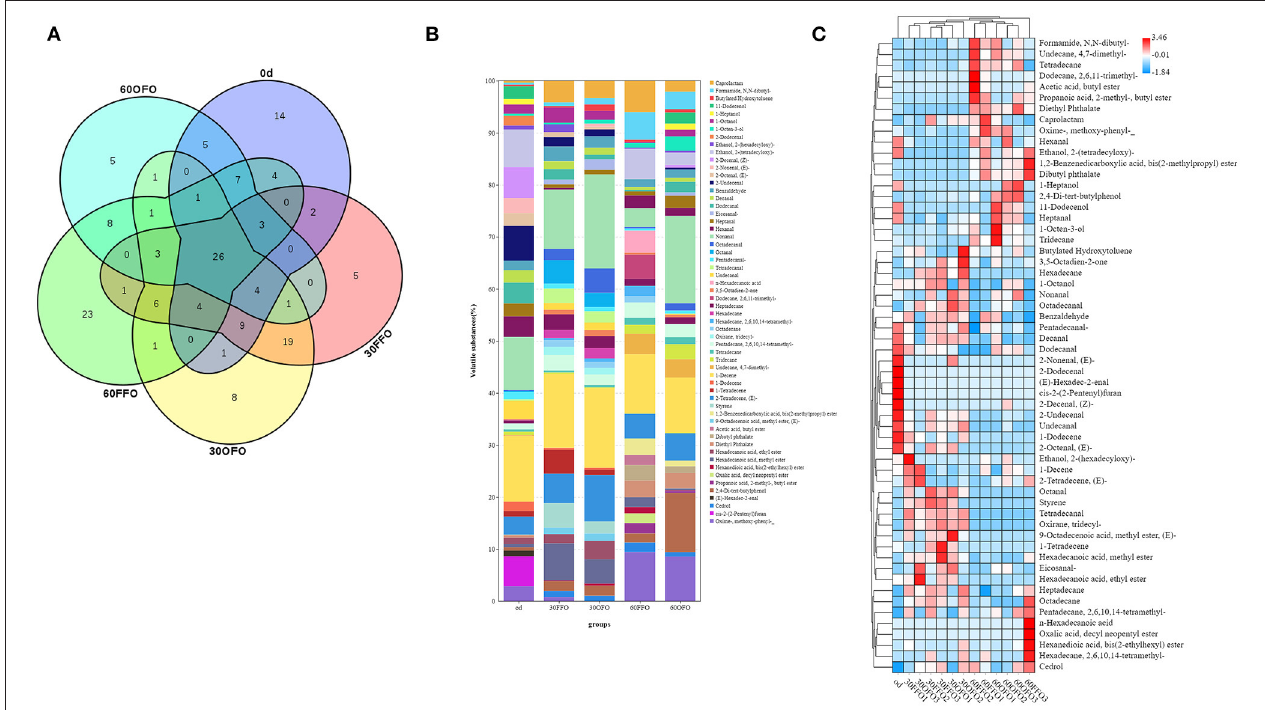
FIGURE 1 | Muscle volatile compounds species of grouper fed different diets.